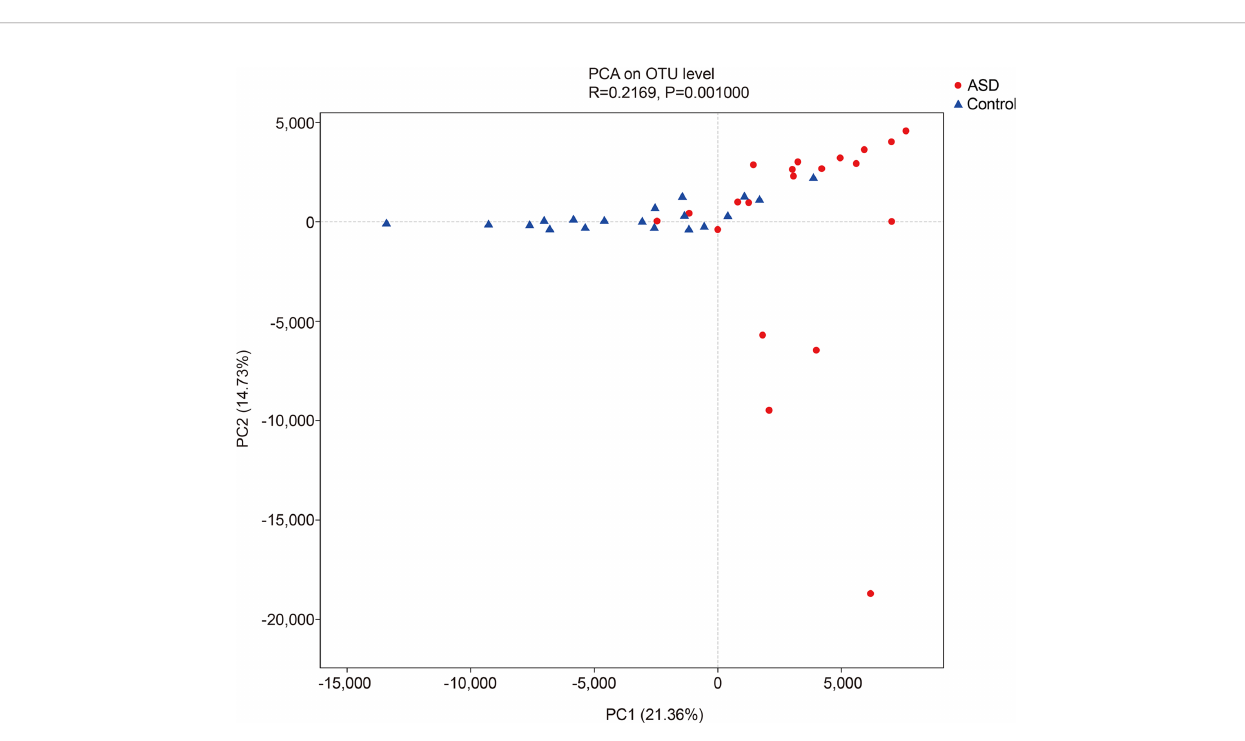
FIGURE 3 | The unweighted UniFrac analysis which focuses on the degree of microbial phylogenetic similarity ( b -diversity) in controls and ASD group (red: ASD group; blue: control group).